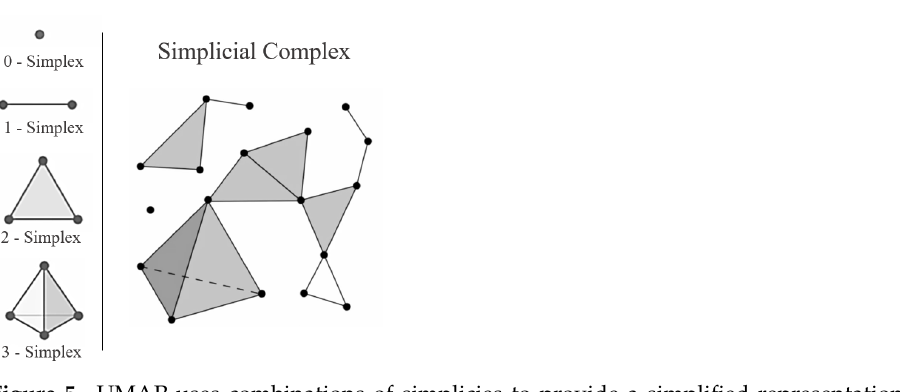
Figure 5. UMAP uses combinations of simplicies to provide a simplified representation of the continuous topological space defined by the high dimensional dataset X while retaining the global and local structures that define the space.